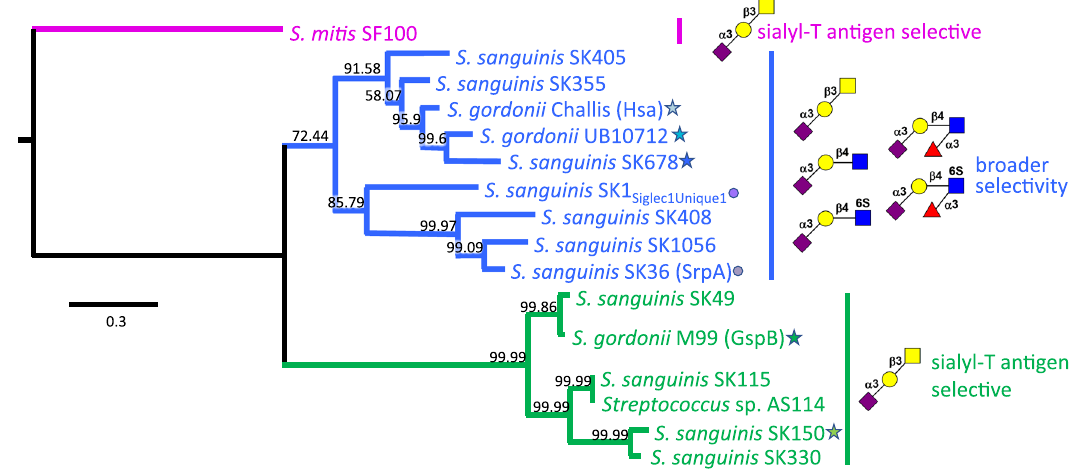
Fig. 2 Phylogeny of select bacterial SLBRs. Phylogenetic analysis of the SLBRs from the indicated strains comprising the tandem Siglec and Unique domains reveals three distinct subgroups. Glycans are depicted using standard symbol nomenclature, with linkage designations shown as numbers and the 6S elaborations shown in red. Characterized SLBR Hsa -like SLBRs ( blue ) bind to two or more of the indicated sialoglycans; the previously-characterized SLBR GspB -like SLBRs ( green ) exhibited narrow selectivity for sialyl-T antigen. The tree is rooted using the distantly related S. mitis SLBR SF100 ( magenta ). SLBRs investigated here are highlighted with a star with the color family re fl ect the branch of tree; later fi gure panels comparing properties of these SLBRs follow this coloring. The structure and ligand binding properties of SLBR SrpA and SLBR SK1 are highlighted with circles as they have previously been reported 13,15,16,23 and are used as comparators in this report. The scale bar indicates the average number of nucleotide substitutions per site, and the numbers on each branch represent the con fi dence of inferred tree topology.